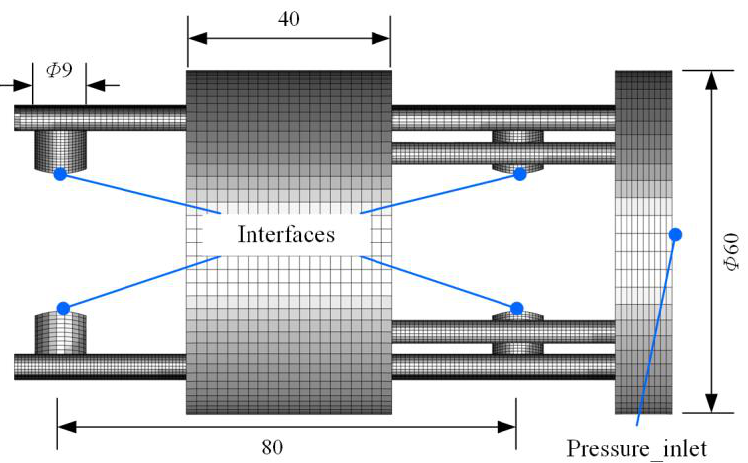
Figure 6. Dimensions and boundary settings of the inlet fluid zone.